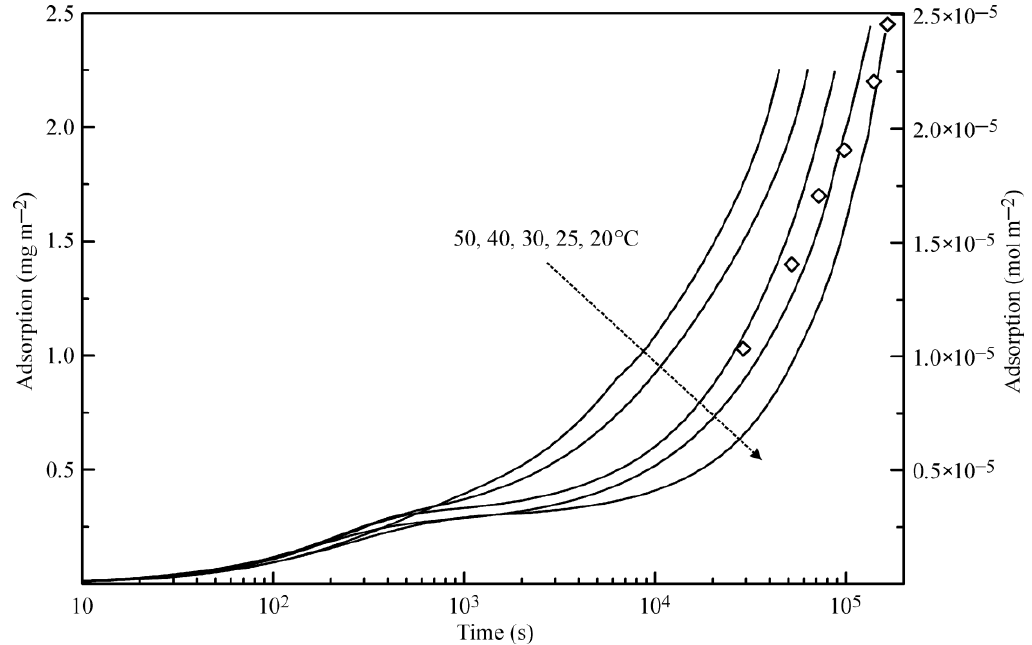
Figure 3. The dynamics of heptane adsorption on water drop surface at various temperatures: curves, theoretical calculations based on the proposed model; points, experimental data obtained in [6]. For detailed explanation, see text.